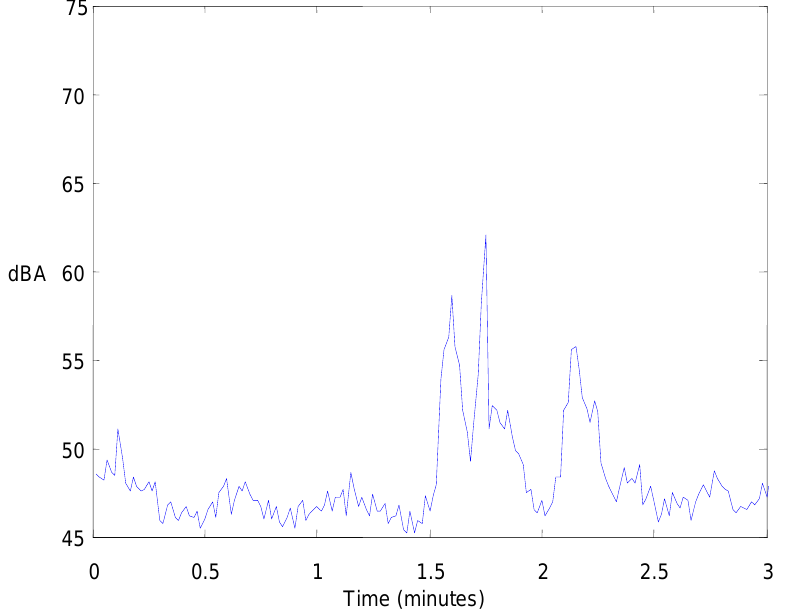
Figure 8. A-weighting equivalent noise level values measured by the sensor node during the first three minutes.